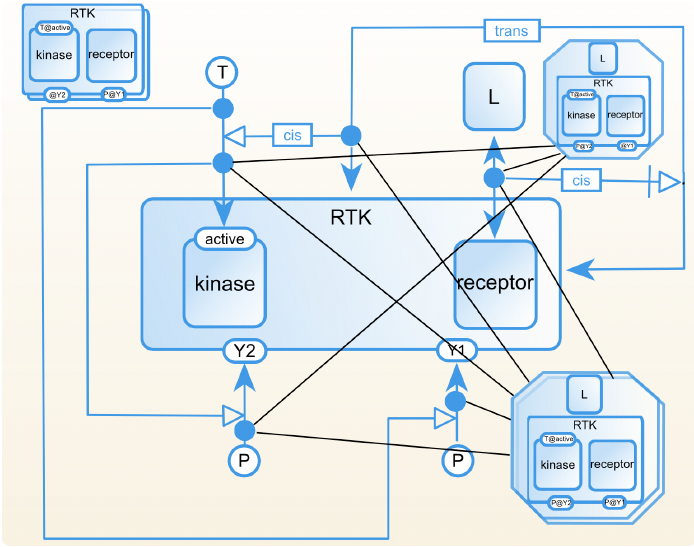
Figure A.8: Receptor tyrosine kinase activation: examples of active kinase complexes are shown. Black lines connect two complexes with outcomes, which definition is compatible with the complex